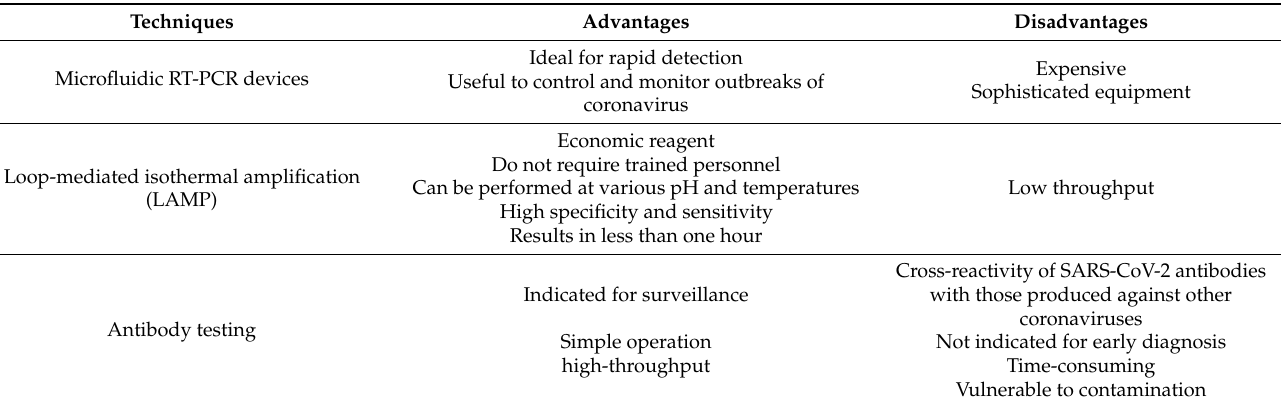
Table 1. Advantages and disadvantages of techniques used for developing rapid